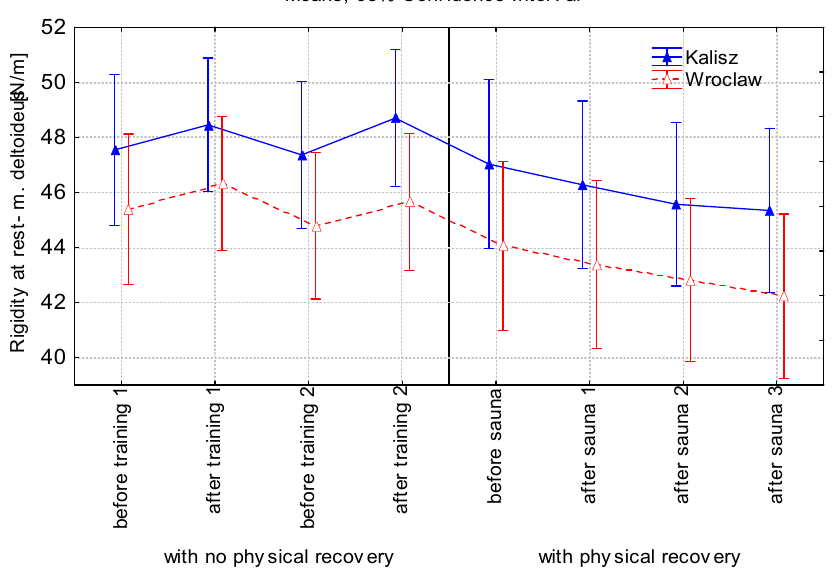
Figure 2. Stiffness differences in the deltoid muscle at rest for disabled swimmers in the training cycle without and with physical recovery Deltoid muscle stiffness measurements at rest: F (7, 126) =, 38324, p =, 91074 Results for the deltoid muscle stiffness under tension before and after the mesocycle training with no physical recovery (stage 1) as well as upon the exit from sauna in the mesocycle training with the recovery (stage 2) prove insignificant (Table 1, 2, Fig.